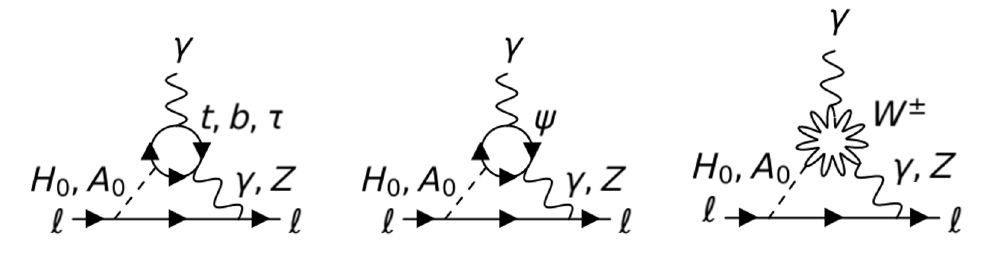
Figure 8 . Two-loop Barr-Zee-type diagrams for electron and muon EDMs in our model. Note that only the diagram in the middle contributes to electron